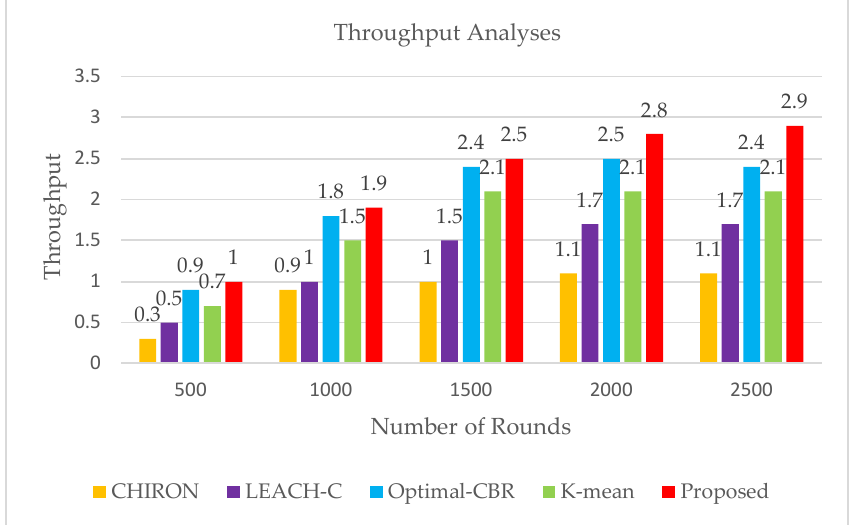
Figure 5. Comparison throughput analyses.